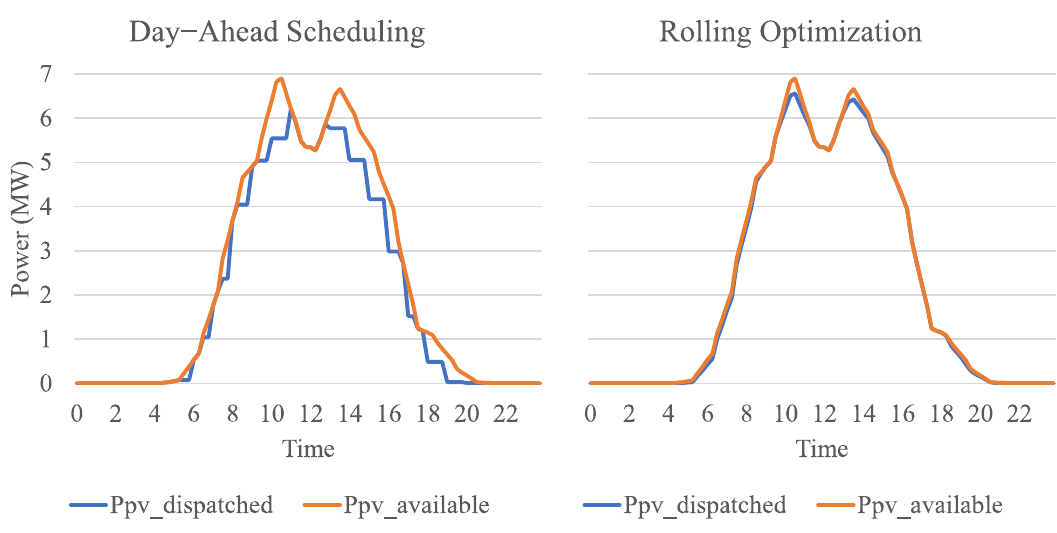
Figure 10. PV dispatching results in normal